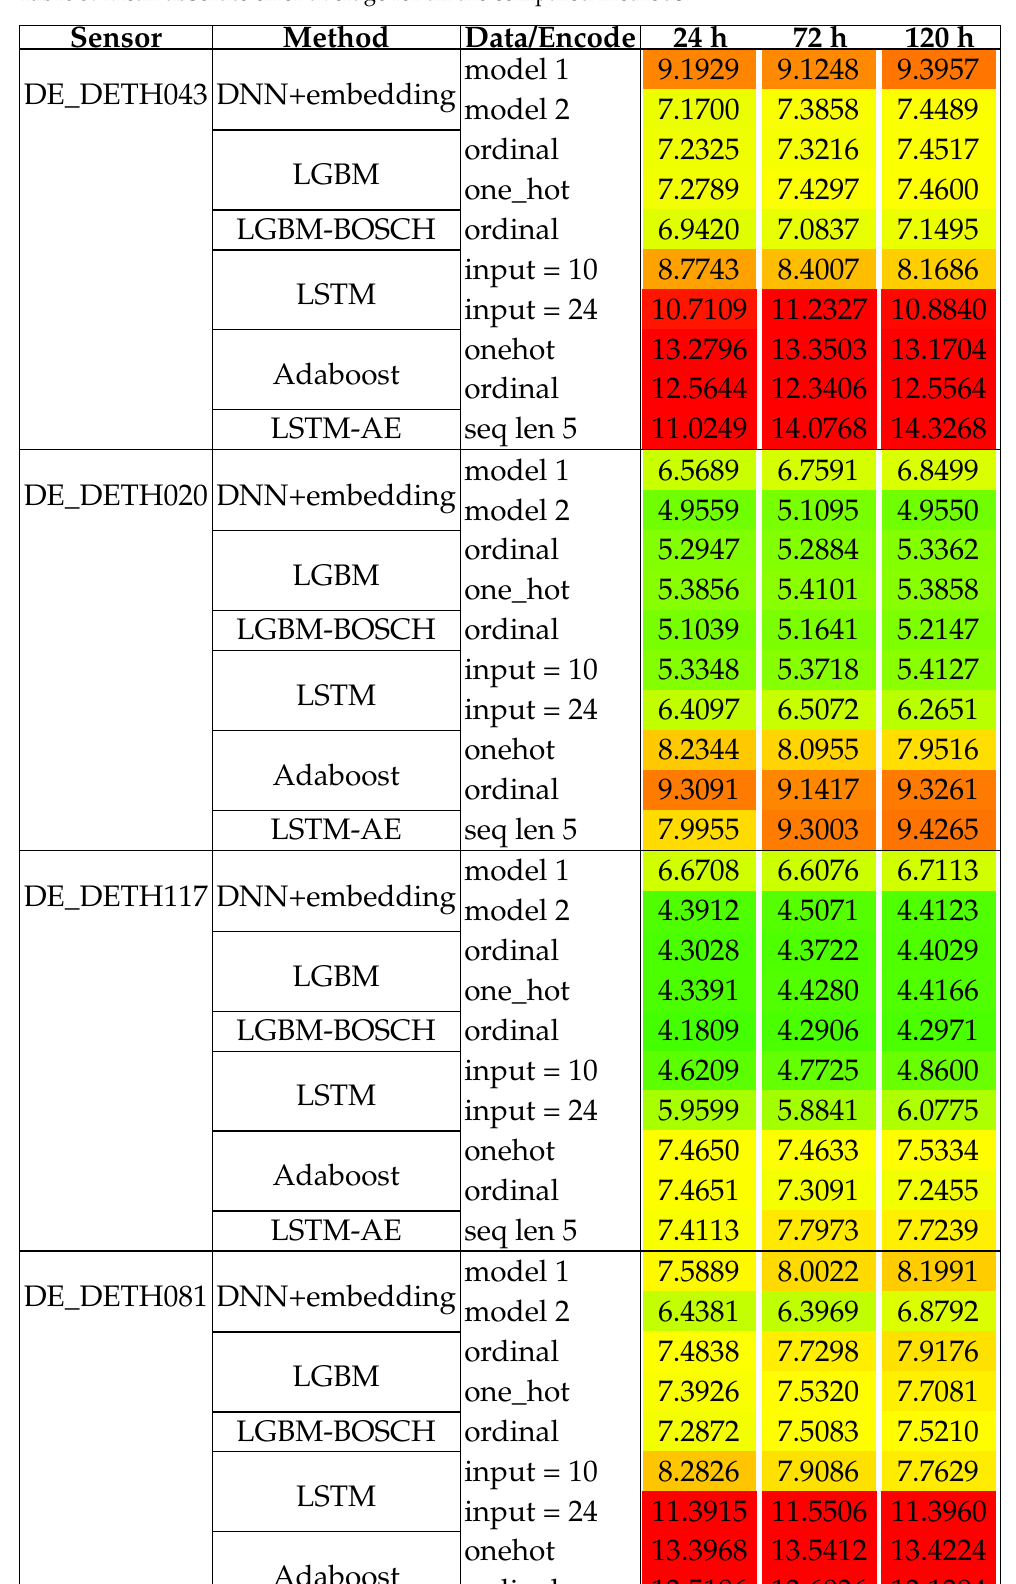
Table 5. Mean absolute error average for all the compared